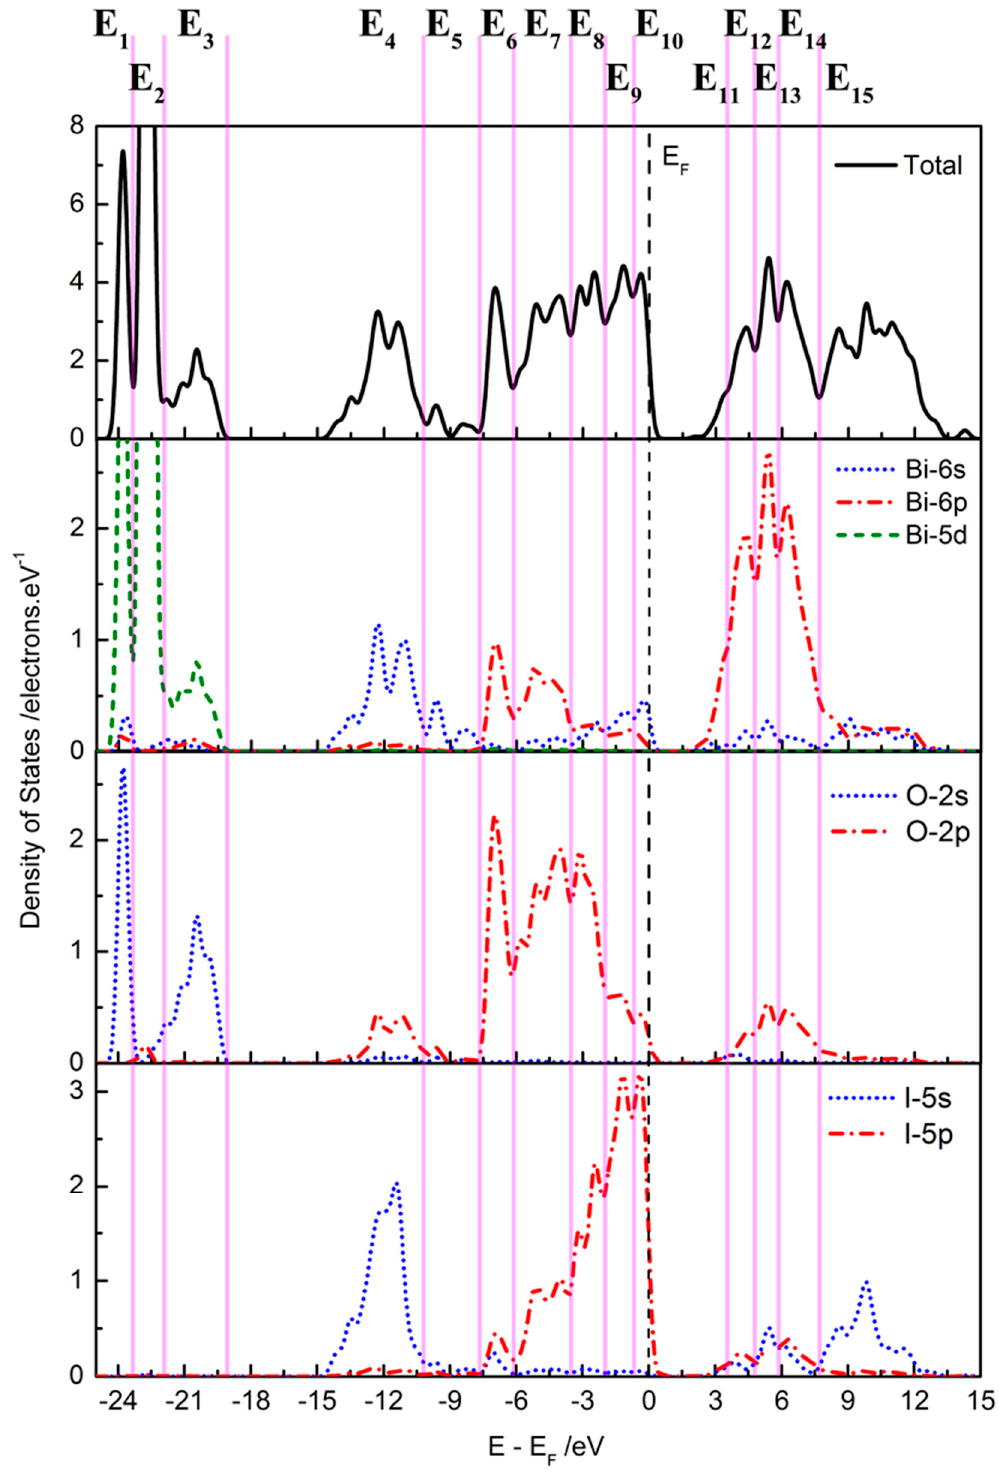
Figure 3. Calculated total and partial DOS (density of states) of BiOI obtained by the HSE06 method. The energy regions E 1 –E 15 are as labeled in Figure The energy regions E 1 –E 15 are as labeled in Figure 2.